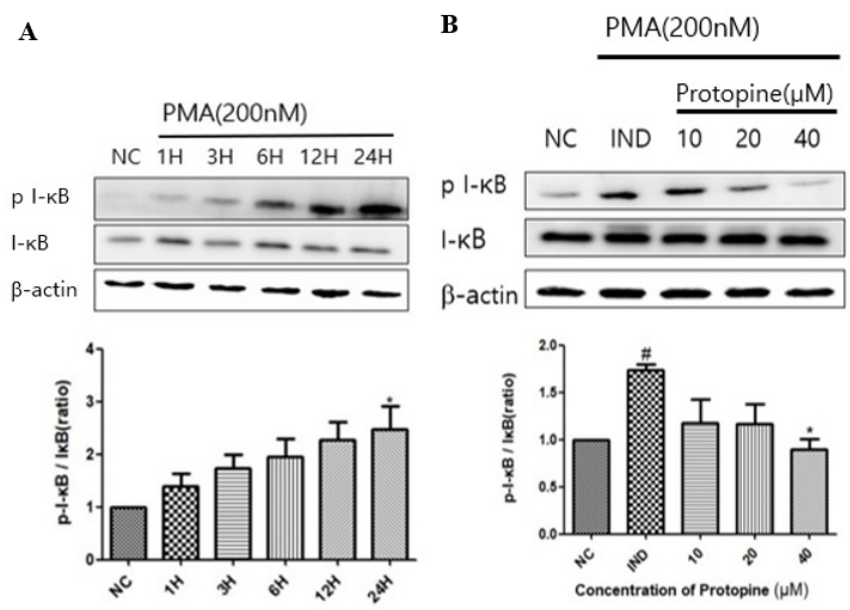
Figure 1. Protopine regulated I- κ B α translocation in PMA-stimulated HepG2 cells. ( A ) Western blot analysis of time-dependent I- κ B α phosphorylation after treatment with PMA 200 nM in HepG2 cells. ( B ) Cells were pretreated with protopine 40 µ M for 1 h and then treated with PMA 200 nM for 24 h. The level of I- κ B α protein phosphorylation was determined by Western blot. The results are presented as the means ± SD. # p < 0.05 indicates significantly different from the normal control. * p < 0.05 indicate a significant difference from the PMA group. NC, normal